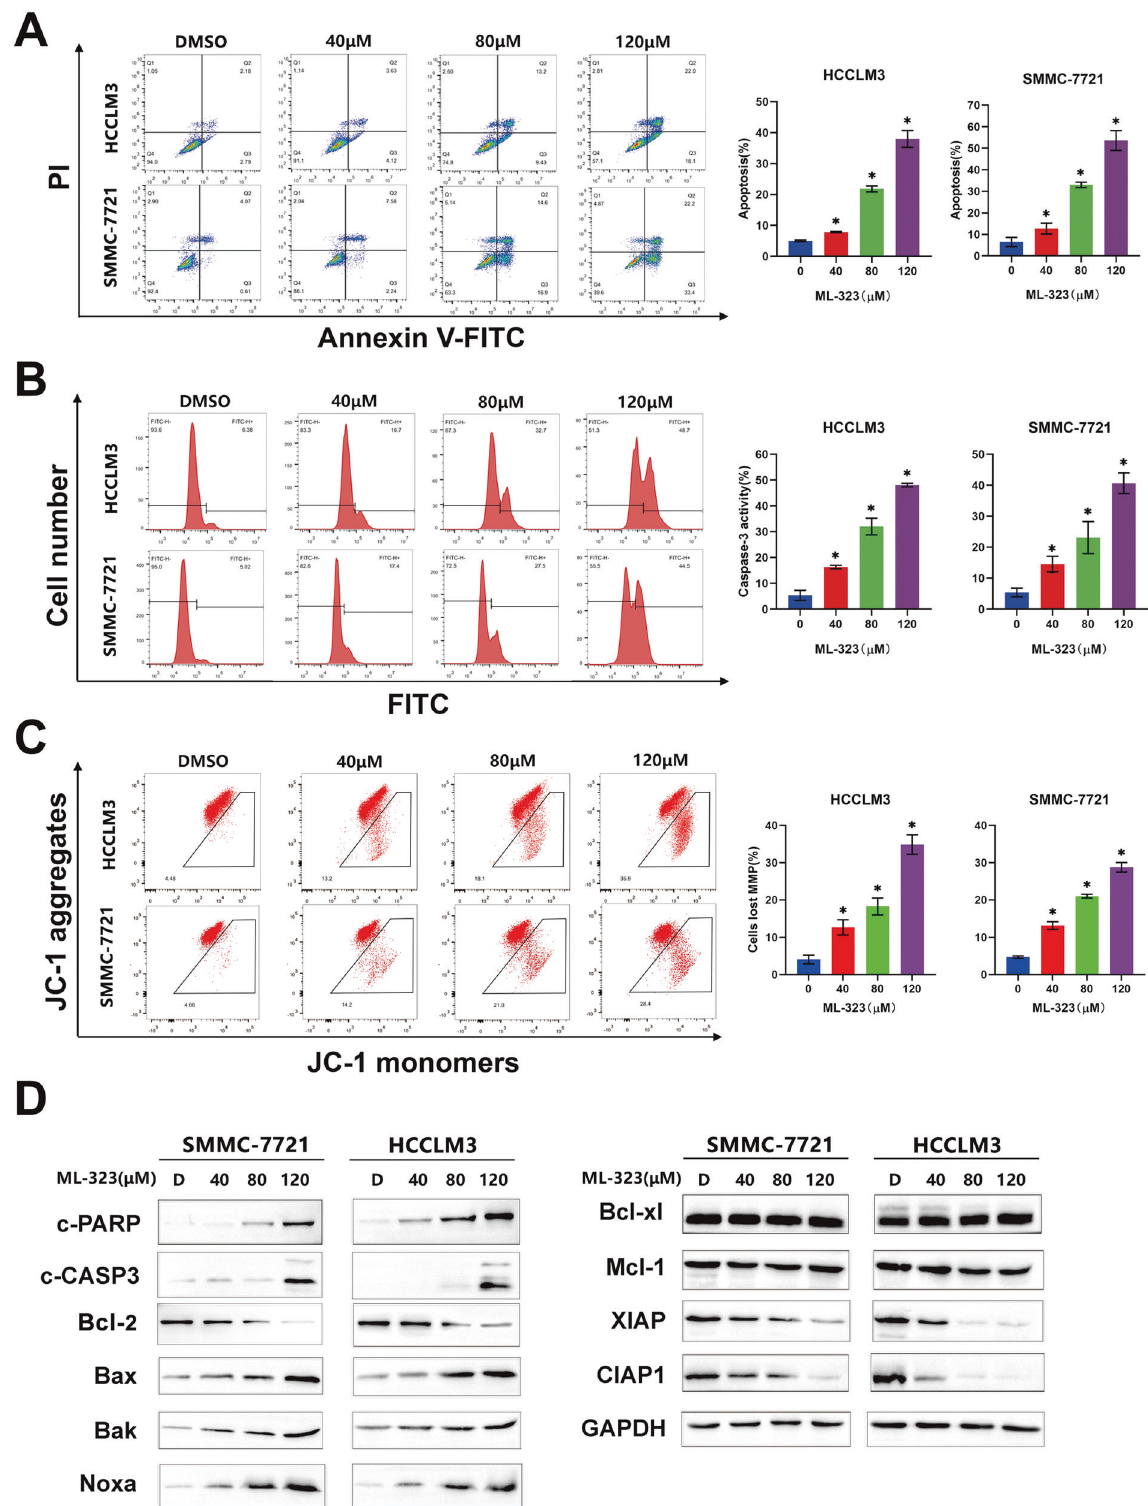
Fig. 2 ML-323 induces intrinsic apoptosis in hepatocarcinoma cancer (HCC) cells. A Fluorescence-activated cell sorting (FACS) analysis using an Annexin V-FITC/PI double-staining kit. Annexin V + cell populations were de fi ned as apoptotic cells. B FACS showing CASP3 activity in ML- 323-treated HCC cells. Data are representative of at least three independent experiments. C FACS analysis of mitochondrial membrane depolarization after ML-323 treatment. D Western blot analysis showing the effect of ML-323 on the expression of apoptotic, pro-apoptotic, and anti-apoptotic proteins. HCCLM3 and SMMC-7721 cells were treated with ML-323 for 48 h. GAPDH was used as a loading control. All the data represent at least three independent experiments ( n = 3; error bars, SD).